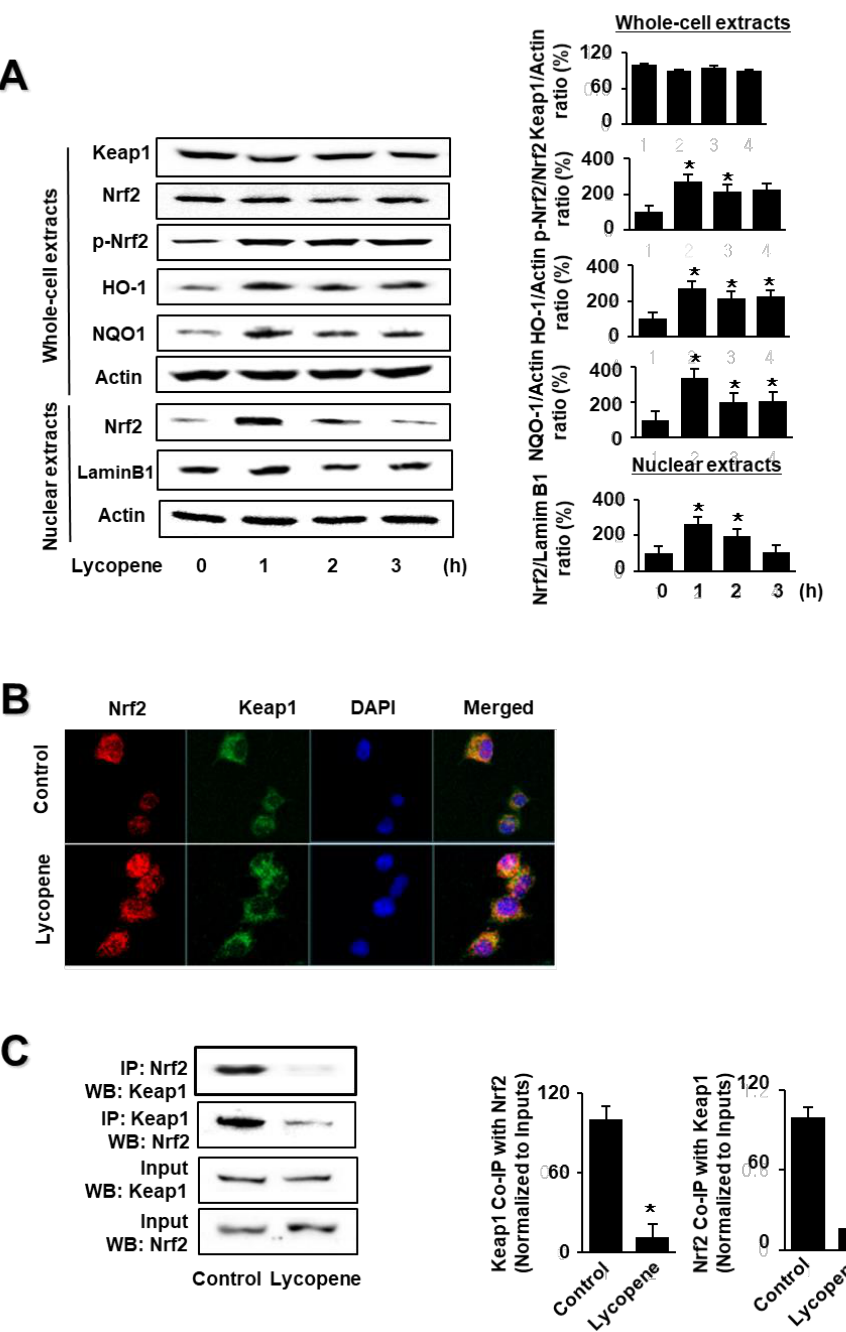
Figure 1. Effect of lycopene on the levels of nuclear factor erythroid-2-related factor 2 (Nrf2), p-Nrf2, Kelch-like ECH-associated protein 1 (Keap1), heme oxygenase-1 (HO-1), NAD(P)H quinone oxi- doreductase 1 (NQO1), and Keap1-bound Nrf2 in AR42J cells. Cells (1 × 10 6 /10 mL/dish) were treated with lycopene for the indicated periods ( A ). Cells (1 × 10 6 /10 mL/dish) were treated with lycopene for 1 h ( B , C ). ( A ) Protein levels were determined by western blot analysis of whole-cell extracts or nuclear extracts, using actin as the loading control and lamin B1 as the index for the nuclear extracts ( left panel ). The densitometry analysis-derived ratios of Keap1/actin, p-Nrf2/Nrf2, HO-1/actin, and NQO1/actin in whole-cell extracts, and Nrf2/lamin B1 in nuclear extracts, represent mean ± S.E. from three immunoblots. The ratio at the start of the experiment (at 0 h) was set at 100% ( right panel ). ( B ) Immunofluorescence was performed to observe the nuclear translocation of Nrf2 using confocal microscopic images of AR42J cells treated with lycopene (0.5 μM ) for 1 h. Nrf2 was visualized using fluorescein/rhodamine-conjugated anti-rabbit IgG antibody (red) with DAPI coun- terstaining (blue) of the same field. ( C ) Interaction between Nrf2 and Keap1 was determined via